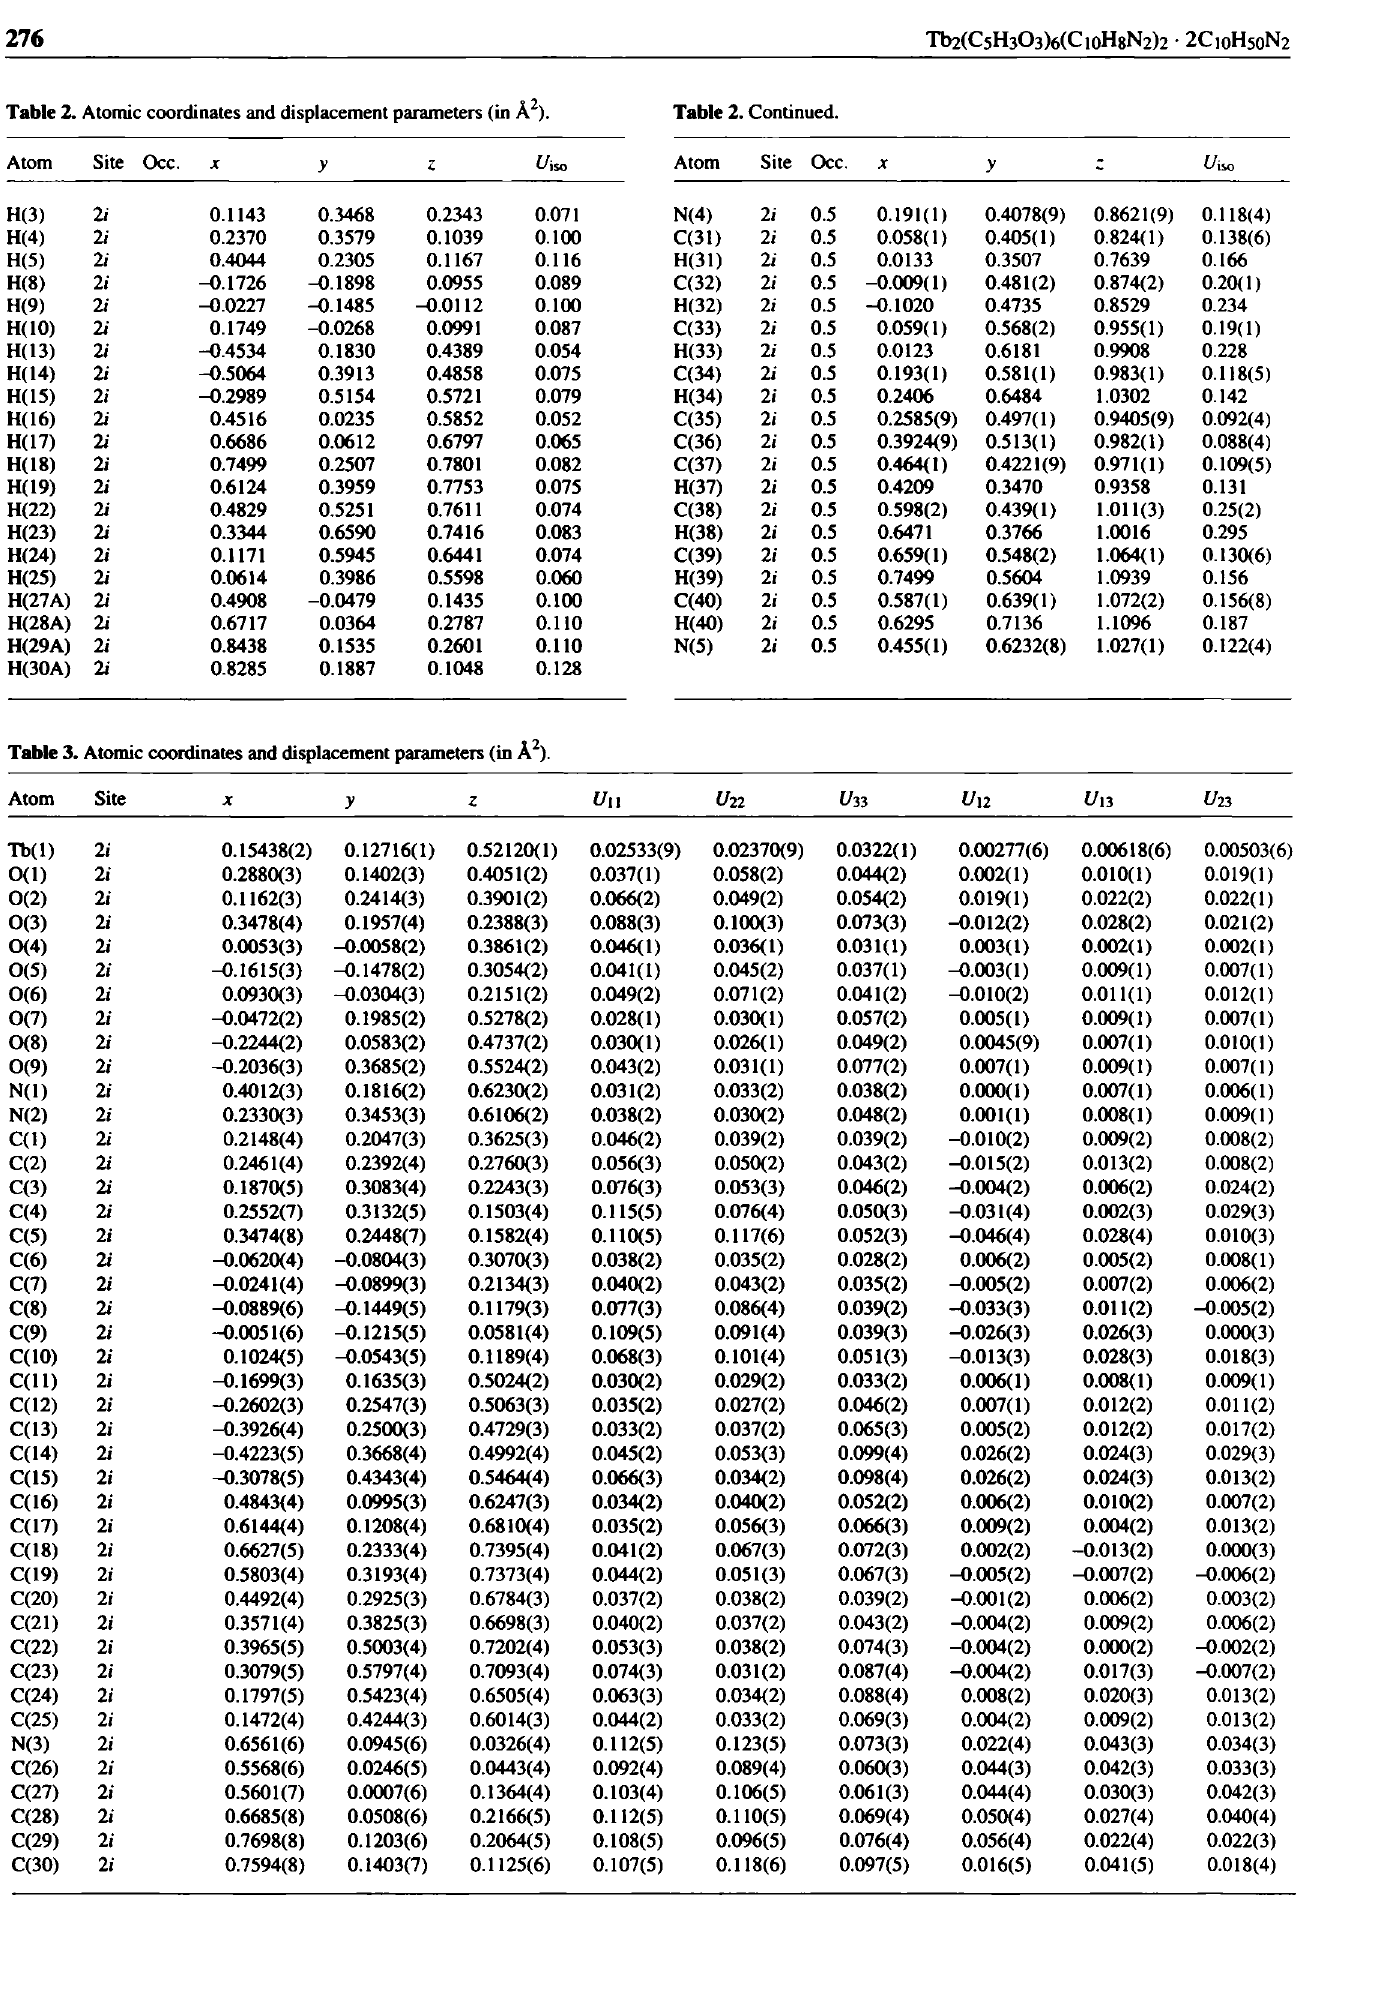
Table 2. Atomic coordinates and displacement parameters (in À 2 ).